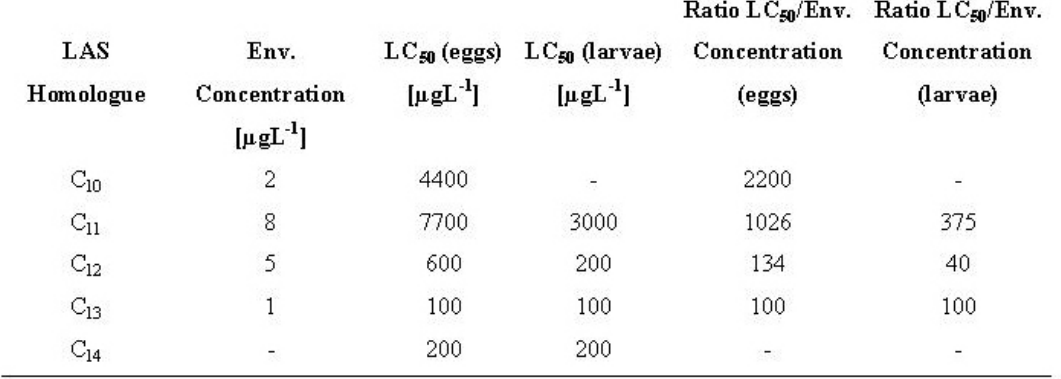
Environmental Concentrations of the Different LAS homologues in the Sancti Petri Channel (San Fernando, Spain), LC (24h) Values for Eggs and Larvae, As Well As the 50 (24 h) Ratio between Environmental Concentration and Obtained LC 50